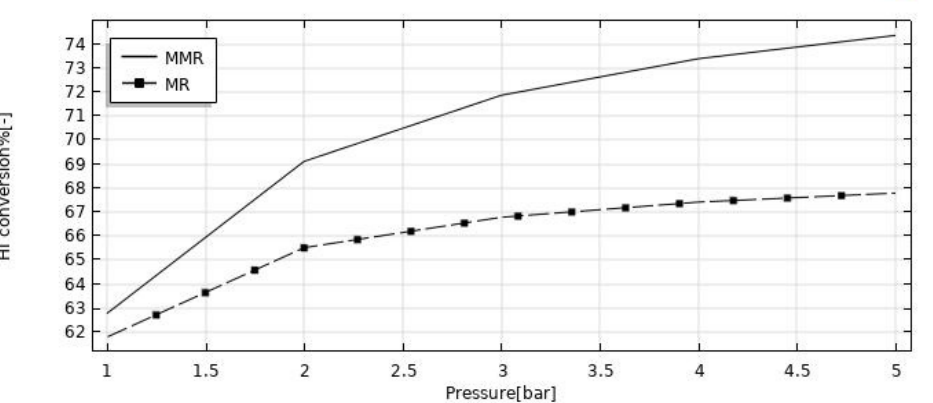
Figure 11. HI conversion vs. reaction pressure at T = 400 °C, feed flow rate = 20 mm 3 /s, and sweep gas flow rate = 333.33 mm 3 /s.